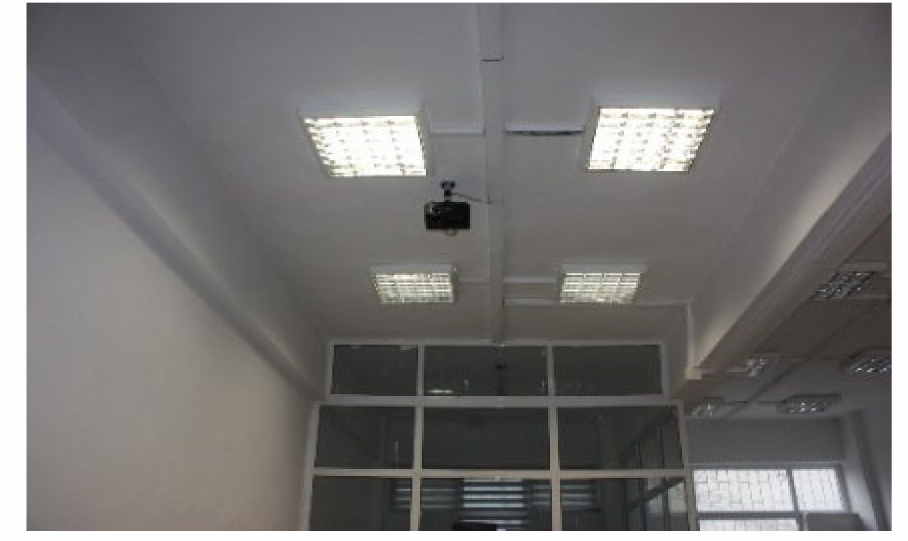
Figure 9. The lighting loads in the